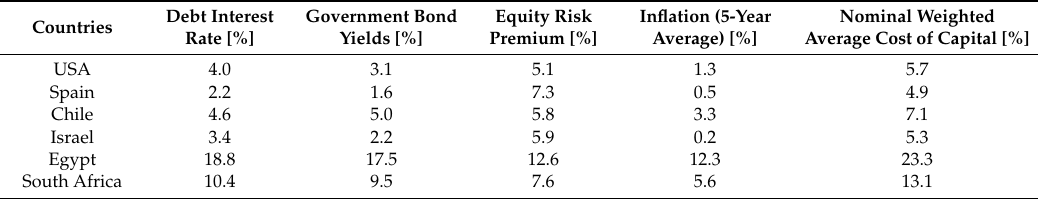
Table 1. Overview of estimated interest rates, inflation, and the weighted average cost of capital for selected countries